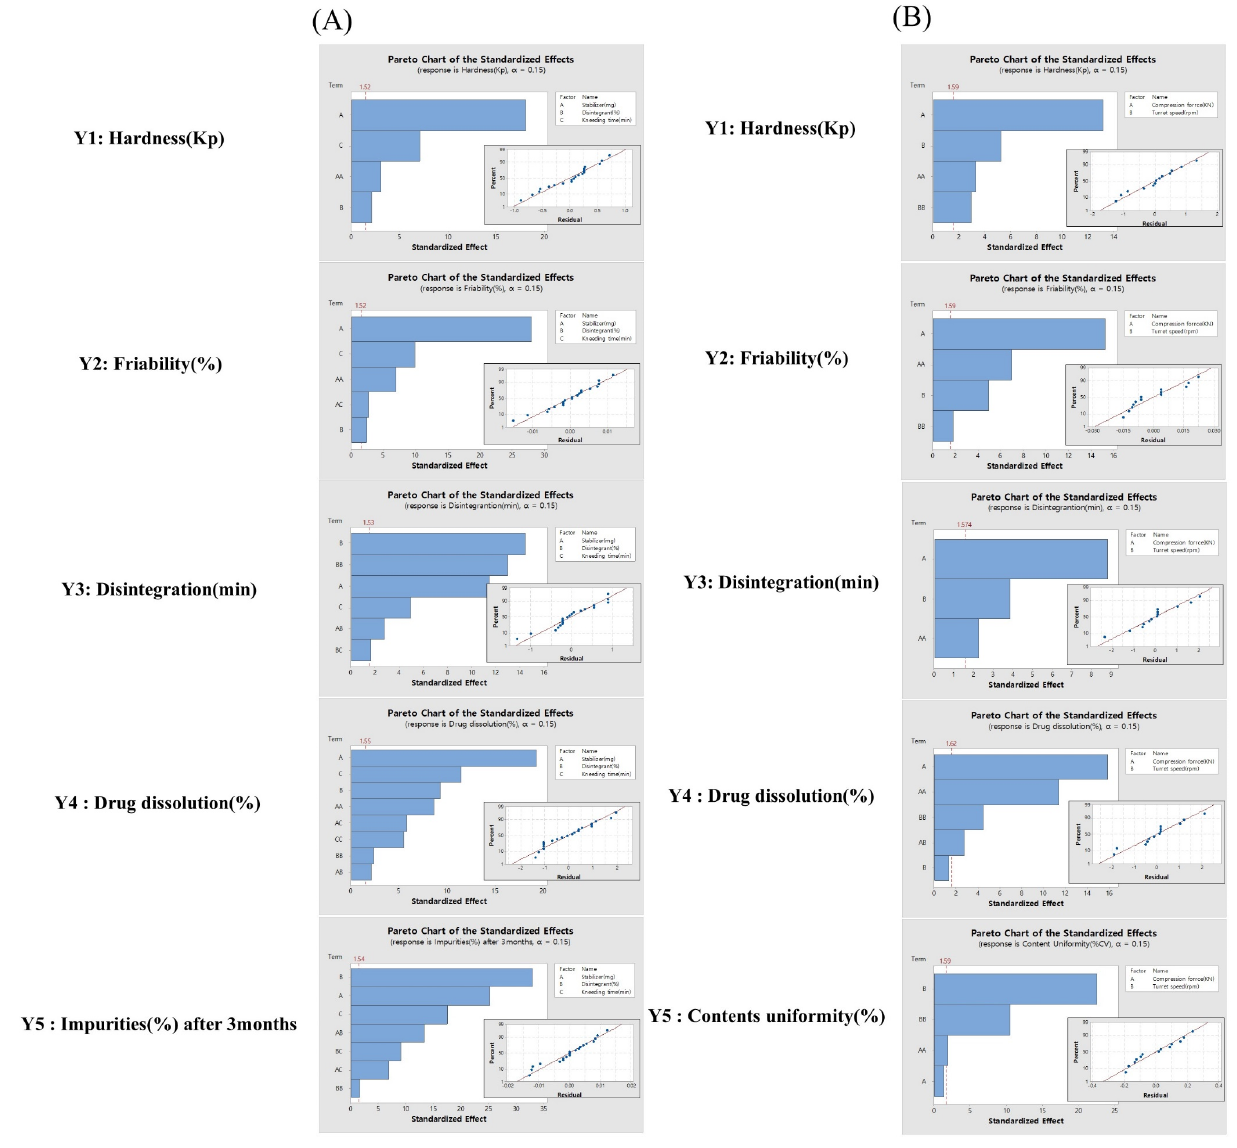
Figure 2. Effect analysis of CMAs and CPPs using a pareto chart and residual plot for wet